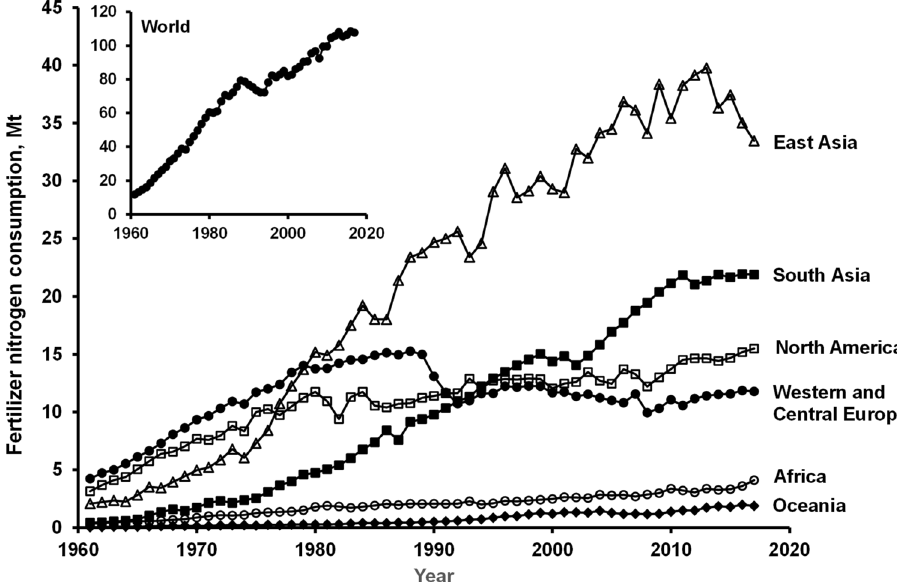
Fig. 1 Fertilizer N consumption pattern since 1961 in differ- ent regions of the world. Data source: http:// ifada ta. ferti